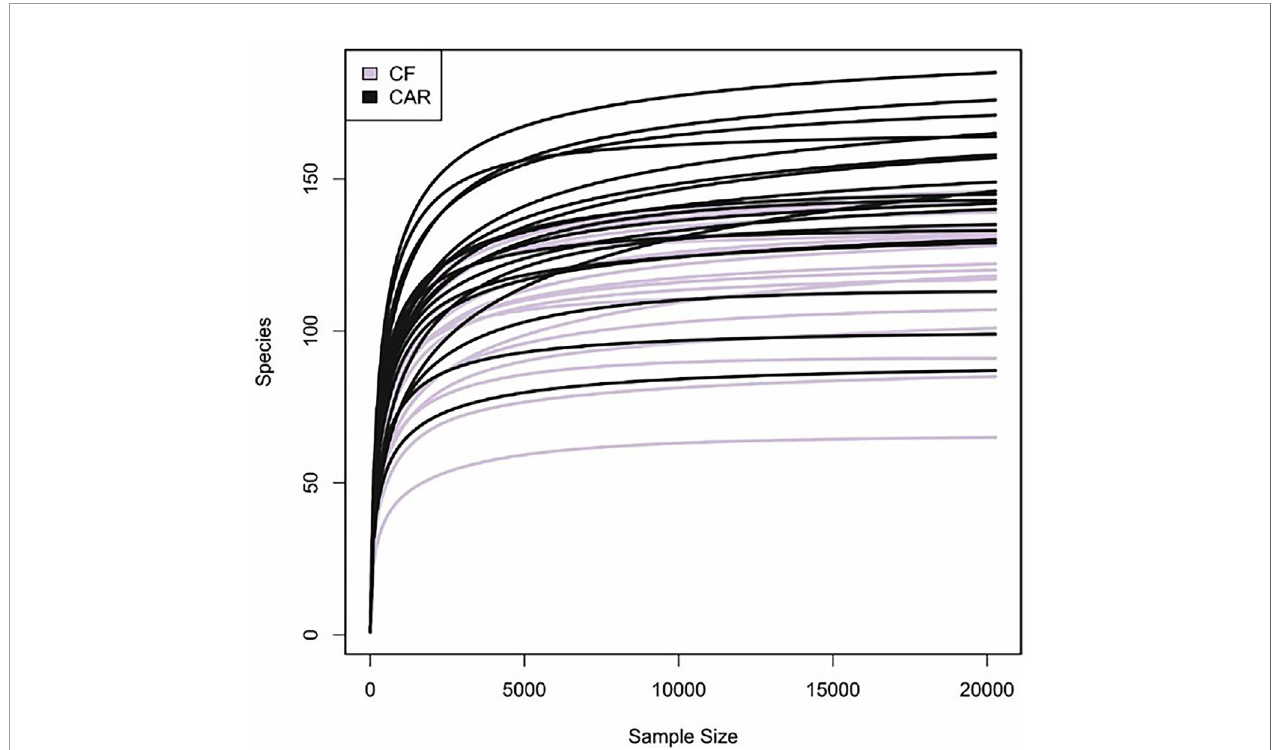
FIGURE 1 | Rarefaction curves of caries (CAR) and caries-free (CF) individuals. The estimated number of bacterial species detected are plotted relative to the number of sequence reads obtained by Illumina sequencing of the 16S rRNA gene. Bacterial richness is stabilized at 20.000 reads (minimum number of reads for all